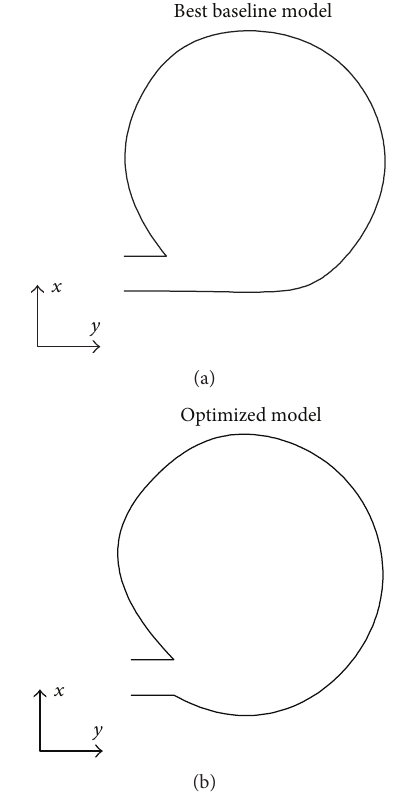
Figure14:Shapeofthebestbaselinemodelandtheoptimizedvolute